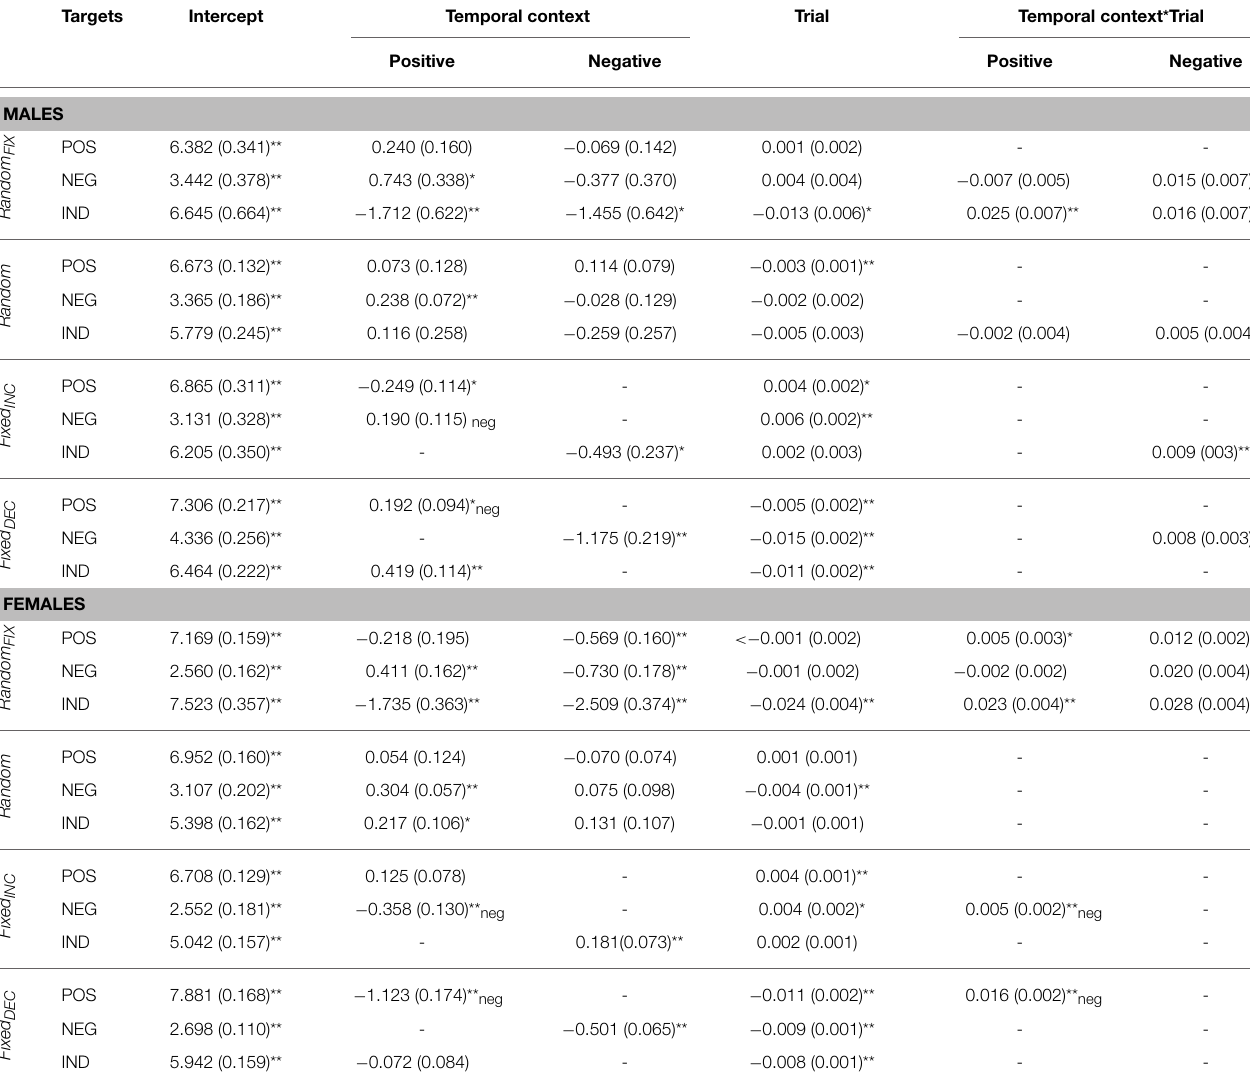
TABLE 3 | Fixed effects parameter estimates for valence ratings according to